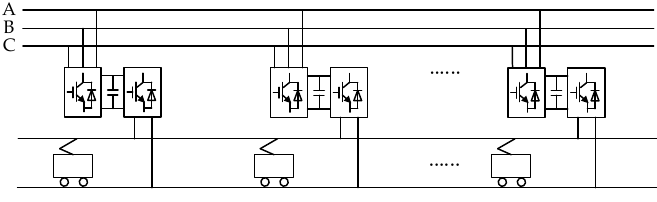
Figure 1. Continuous cophase power supply system.